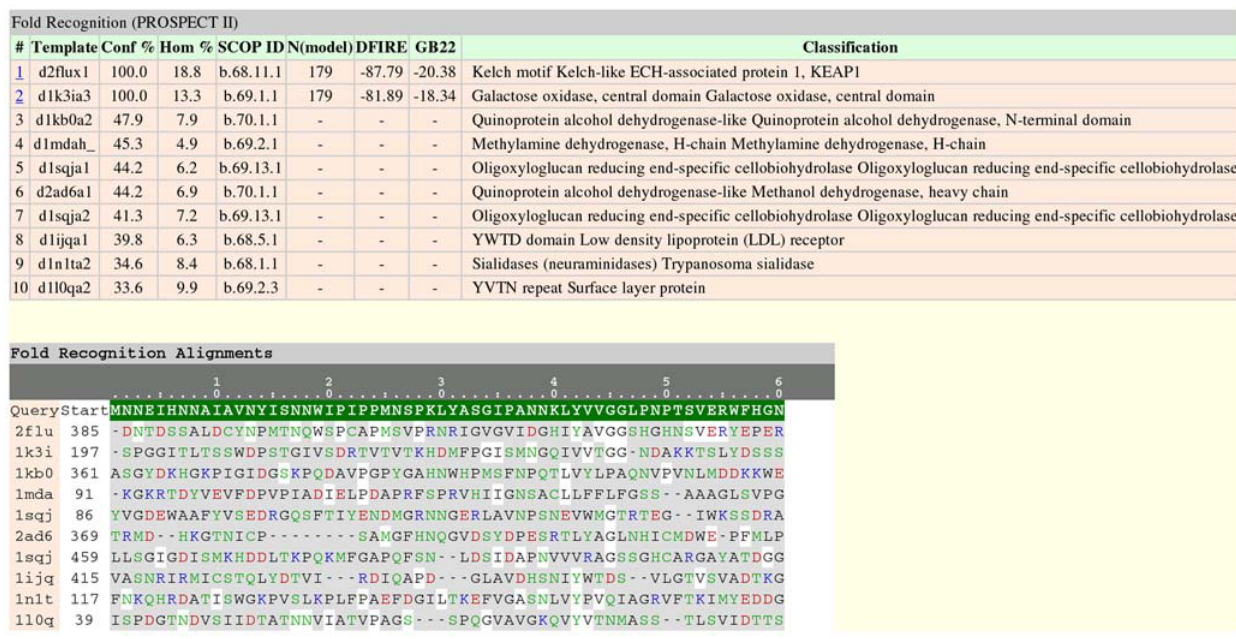
Figure 3. Screenshot of the pipeline-rendered fold recognition results in HTML format for variola protein NP_042071.1. This picture truncates the alignment after the first block of 60 residues.